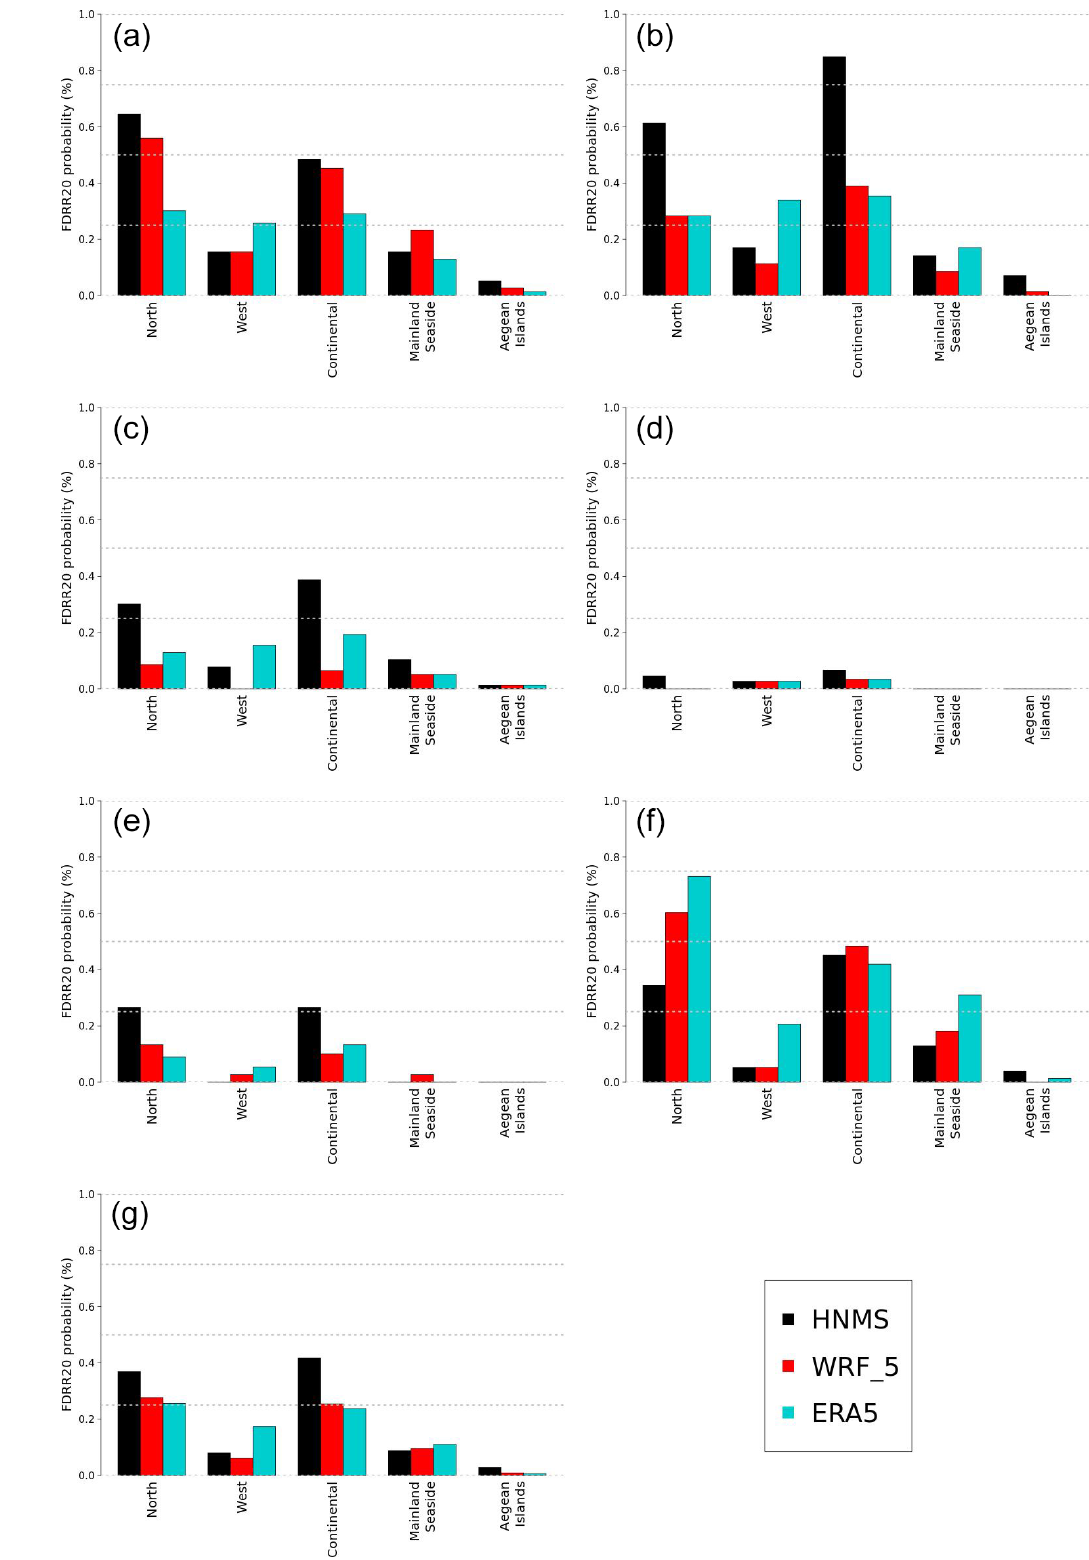
Figure 2. RR20-FD aggregated probabilities for HNMS, WRF_5 and ERA5 five station categories for the months (a) January, (b) February, (c) March, (d) April, (e) November, (f) December and (g) for the entire season November–April.